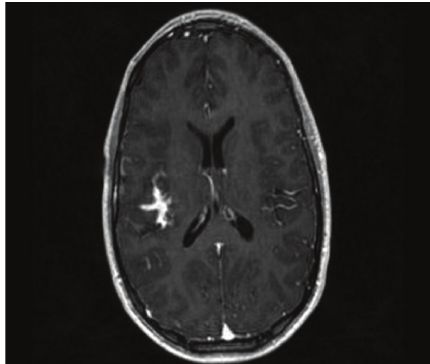
Figure 3: Relatively T1-weighted gradient echo axial MRI with gadolinium contrast shows serpentine enhancement in depths of right sylvian fissure compatible with presumed vascular malforma-